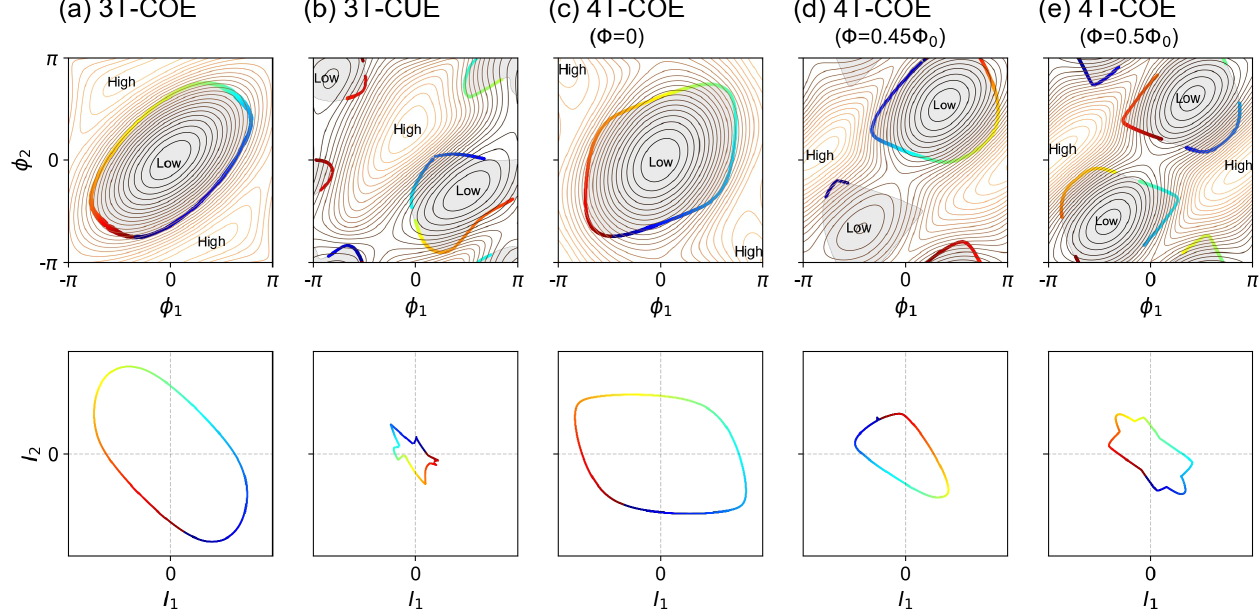
FIG. 8. Partitioning of CCC in the phase space. (Top) Contour map of the ground state energy and (bottom) the corresponding CCC of the three-terminal junctions without a loop and four-terminal junctions with a loop. (a) Three-terminal (3T), no B field, (b) Three- terminal (3T), nonzero B field, (c) Four-terminal (4T) with a loop Φ ¼ 0 , (d) Φ ¼ 0 . 45 Φ 0 , (e) Φ ¼ 0 . 5 Φ 0 . The CCC is a boundary of all possible configurations of ( I 1 , I 2 ). Each configuration ( I 1 , I 2 ) of color on the CCC is given by the phase values ( ϕ 1 , ϕ 2 ) of the same color in the corresponding energy contour map. The shaded area is where the two Hessian eigenvalues are